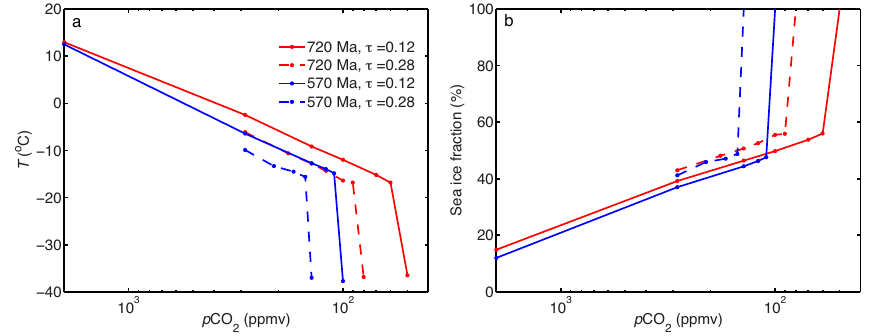
Fig. 7. The change of (a) global mean surface temperature and (b) sea-ice fraction with CO 2 . The dots represent the equilibrium state of the runs shown in Figs. 4 and 5. TSI = 0.94TSI 0 for all the simulations. The global mean surface temperature obtained for the hard snowball state (lowest points in (a) ) may be an underestimate because the model either failed or was terminated soon after the climate enters into this cold state. Moreover, the sea-ice parameterization in the model may not be suitable for simulating sea ice in a hard snowball.